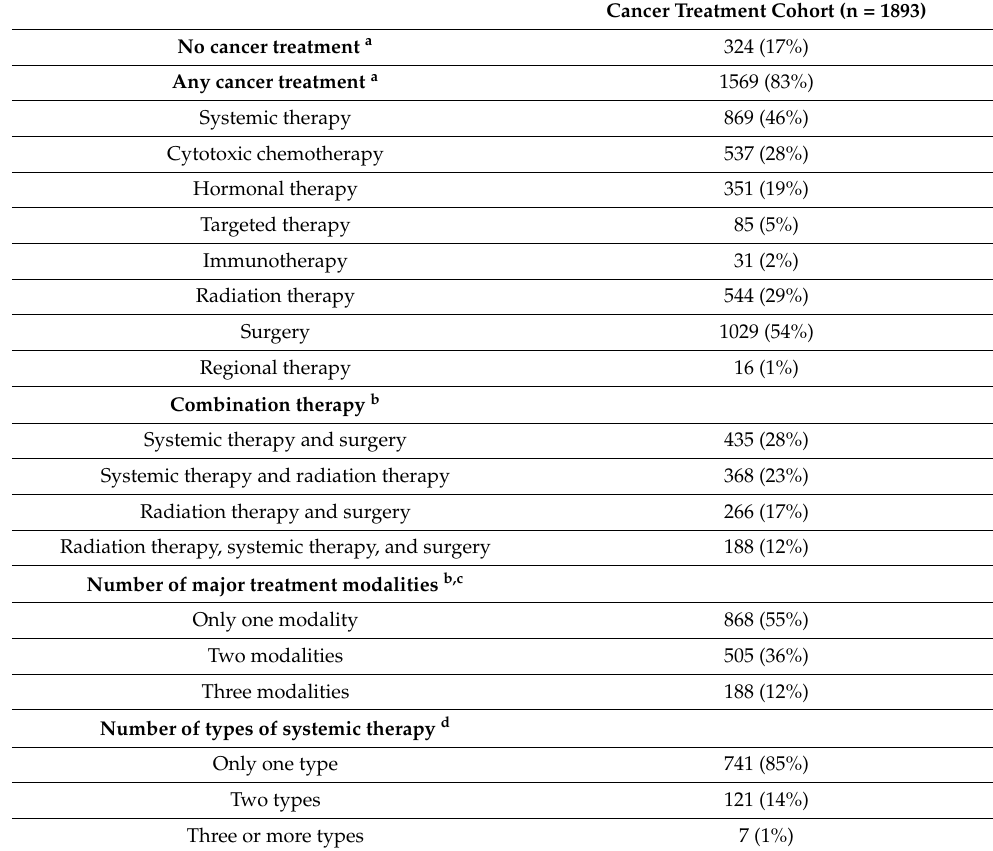
Table 2. Characteristics of the incident cancer diagnosed following randomisation and the treatment in participants who received a post-randomisation cancer diagnosis during